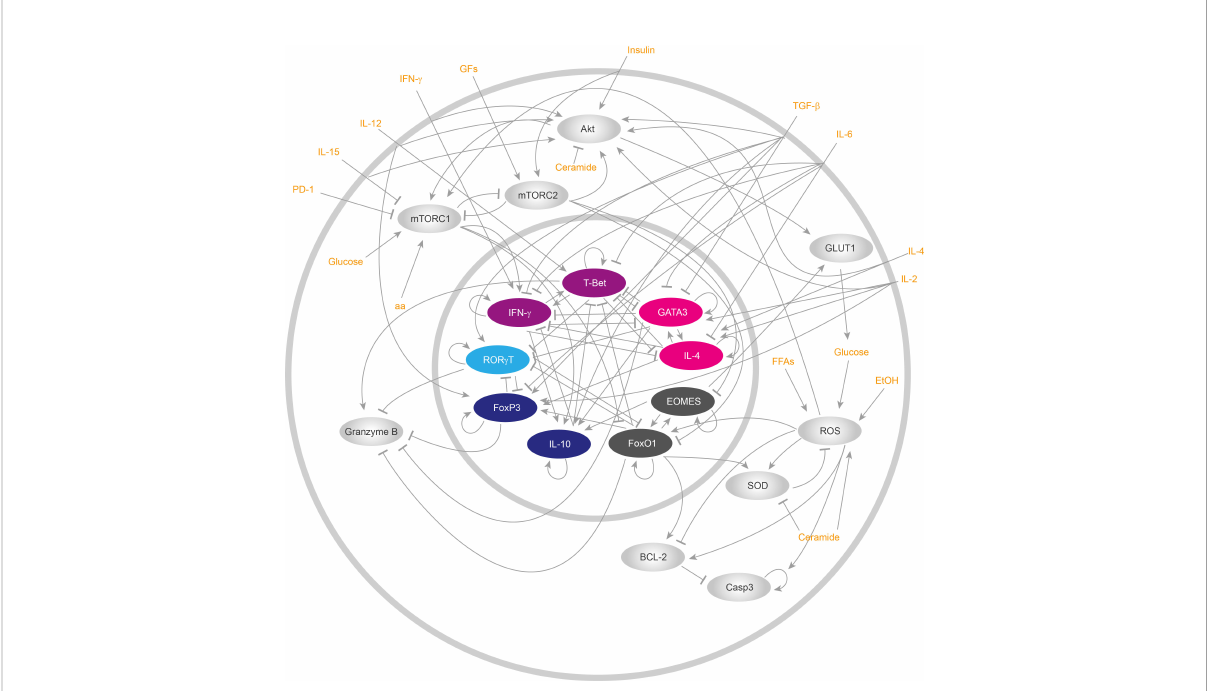
FIGURE 1 Reduced gene regulatory network of CD8+ T cells. ReducedCD8+ T lymphocyte gene regulatory network. All cytoplasmic components are drawn in silver gray, while nuclear components are represented with colors. All inputs of the networks, i.e., all external stimuli that either activate or repress the functioning of the network, are displayed in